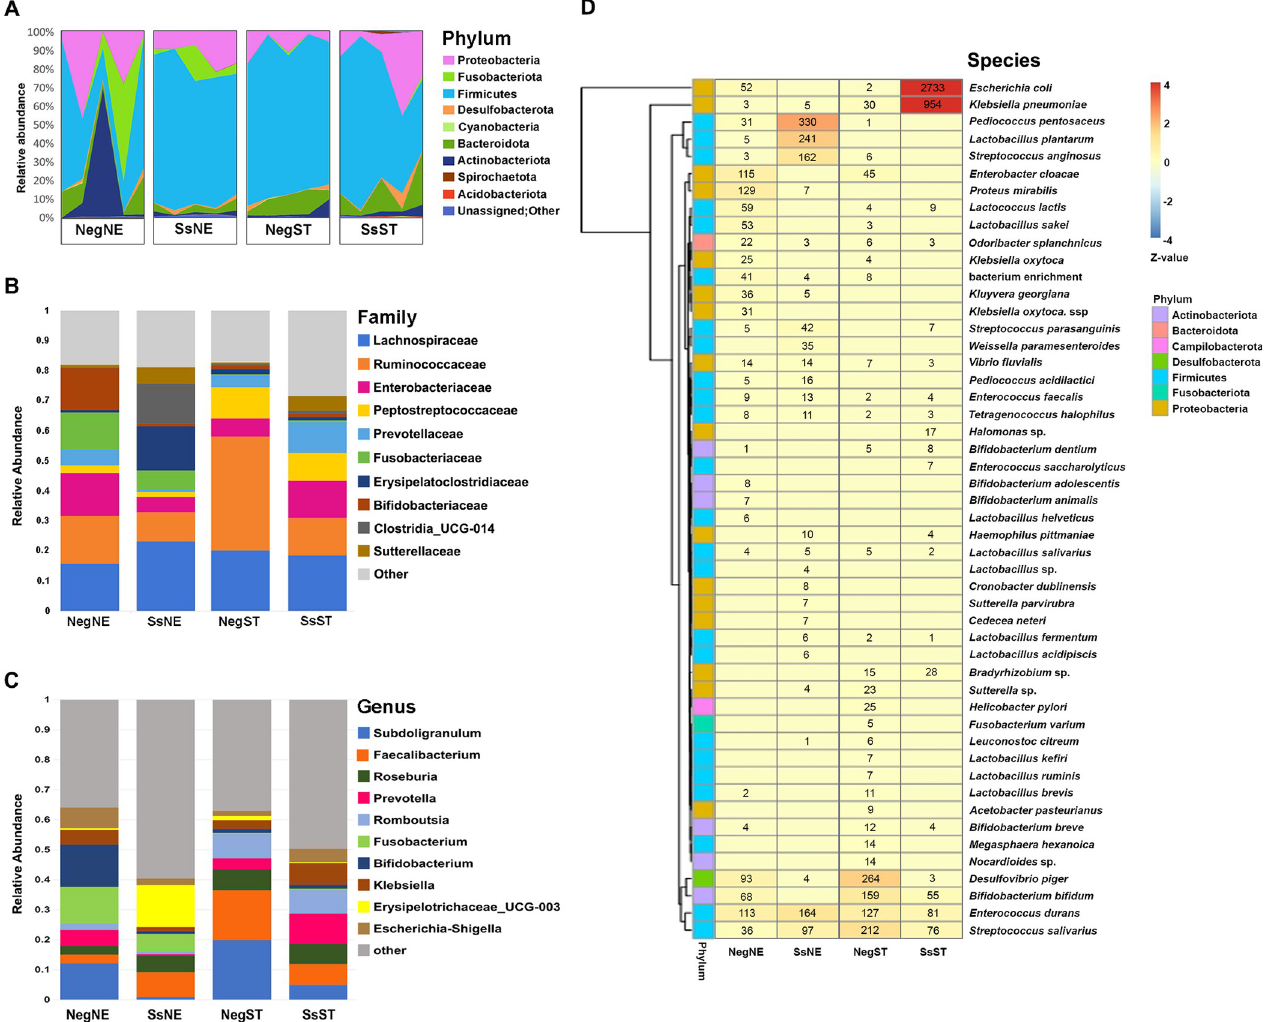
Fig 1. Species distribution of the gut microbiota of two endemic areas of strongyloidiasis in terms of the most abundant. (A) Area graph showing relative proportions of the most abundant phyla (n = 5 in each group). (B) The top 10 families and (C) genera in terms of relative abundance in each sample group. (D) Hierarchical clustering heatmap of dominant species plotted by the absolute z-value. The colors in the heatmap refer to the species abundance, according to the color bar on the right. Numbers in the heatmap are reads per sample.